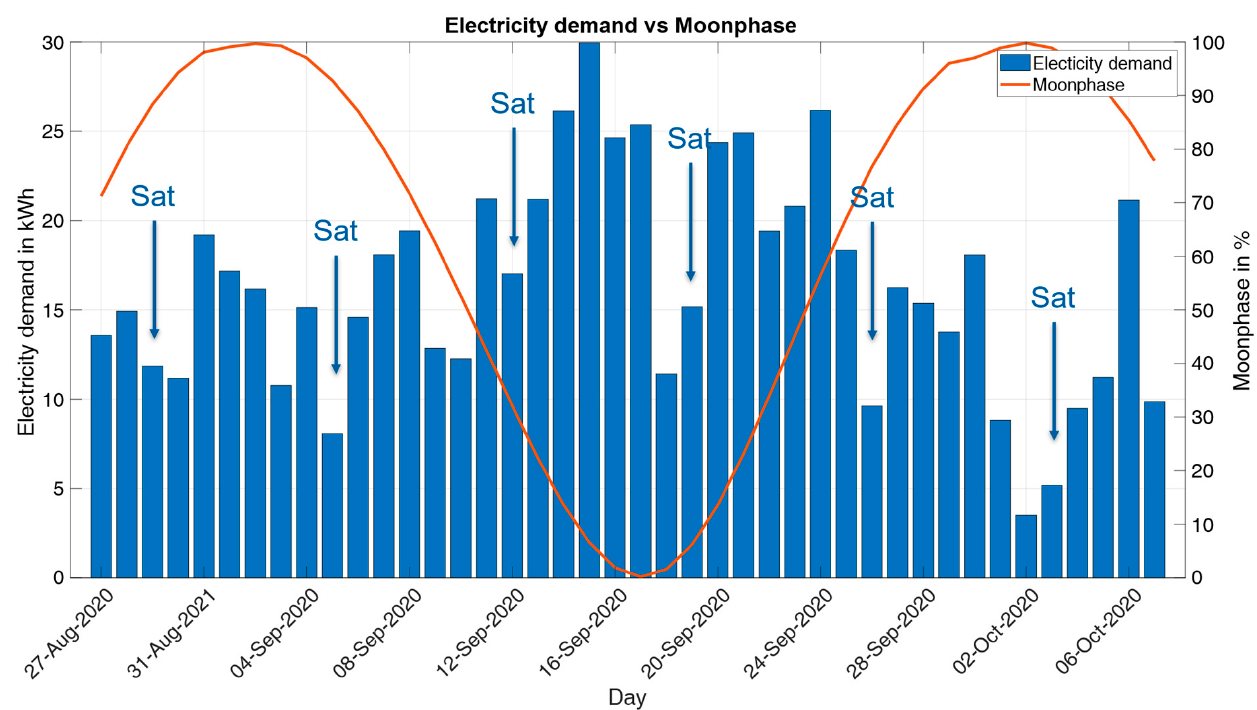
Figure 8. Daily electricity demand in correlation to moon phases for the normal operation period.